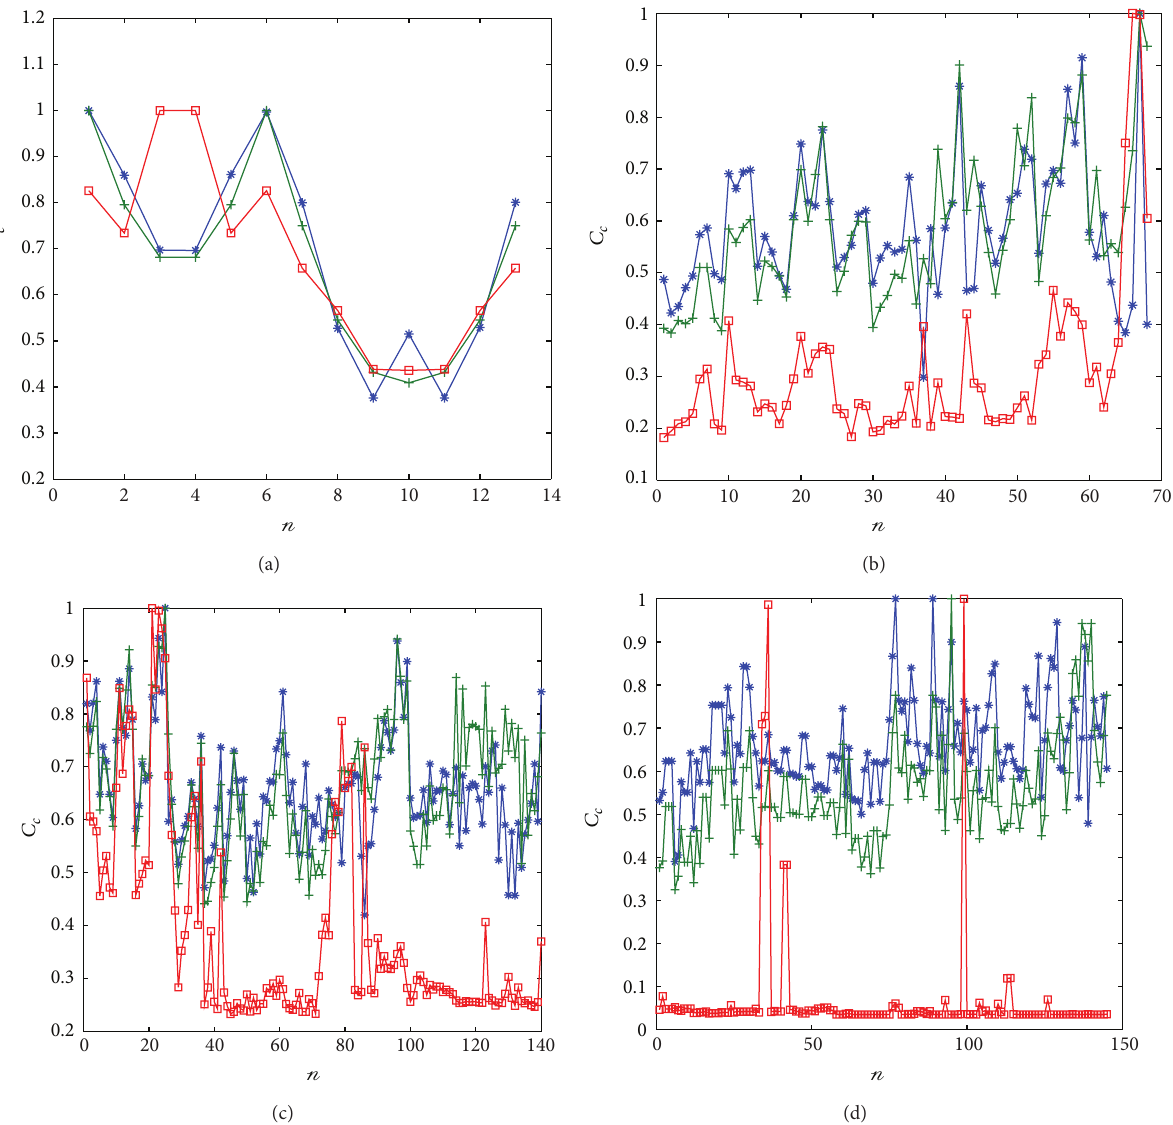
Figure 7: Closeness indices of test power grids (a) G 4 , (b) G 16 , (c) G 48 , and (d) G 50 obtained using three different definitions: the